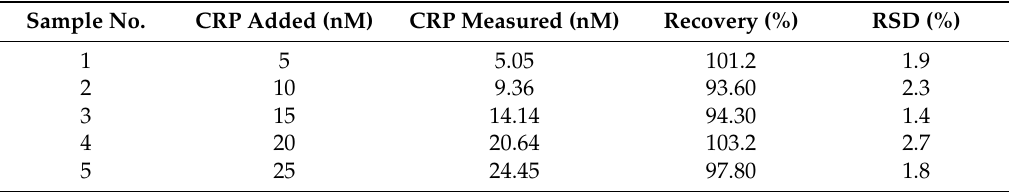
Table 3. Measurements of CRP antigen concentrations in human blood serum samples. Sample